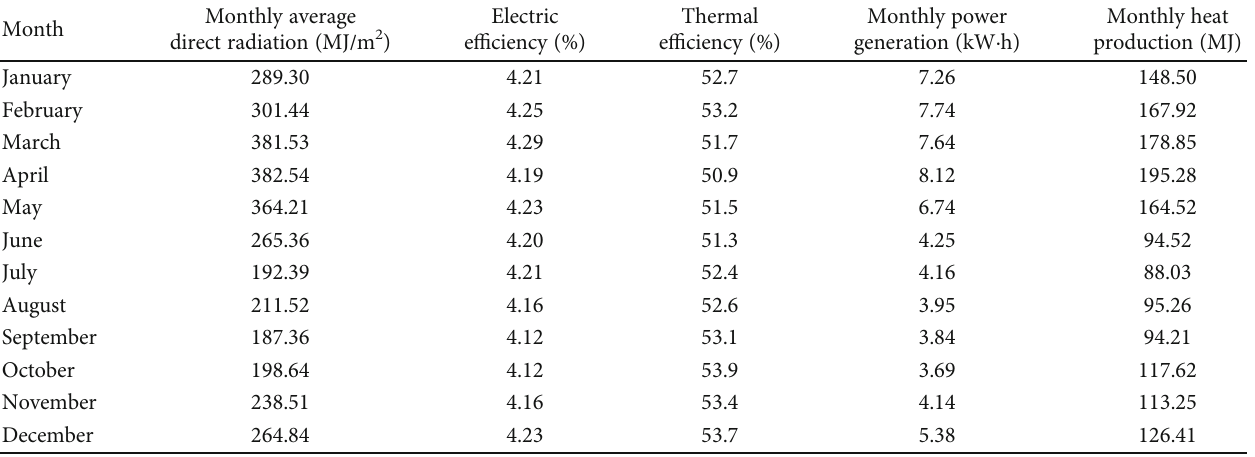
Table 6: Monthly power and heat output of trough type concentrated photovoltaic power generation system.